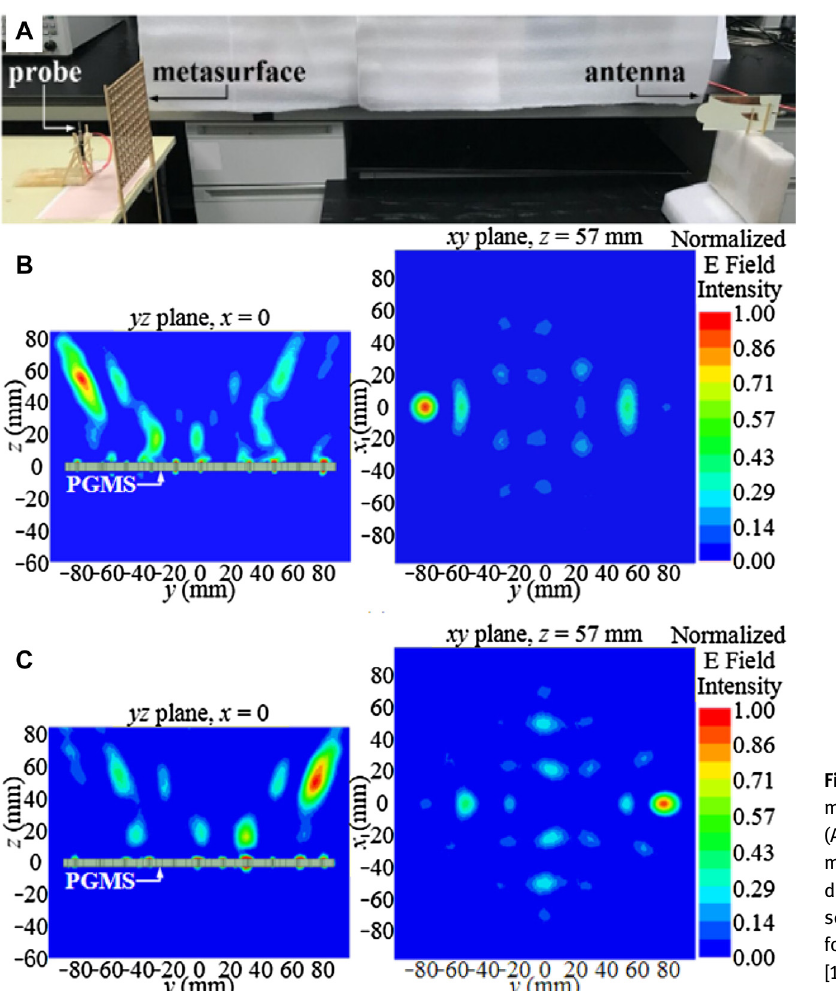
Figure 22: Polarization-controllable metasuface. (A) Polarization manipulation metamaterial. (B) and (C) The spatial distributions of the simulated normalized scattering electric fi eld intensity at 14 GHz, for the x -polarization and y -polarization [113]. Reprinted from [113], with the permission of IEEE